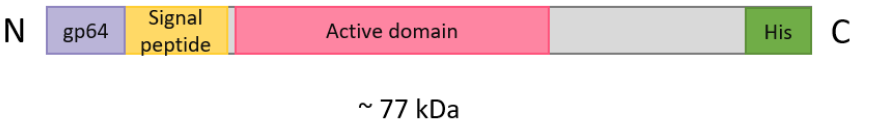
Figure 2. Schematic structure of the recombinant full-length β -gal from A. vulgaris (GenBank: A0A0B7AQJ9). The full-length protein consists of a putative N-terminal signal peptide (yellow), a putative active domain (red), and further gene sequence (grey). A gp64 leader sequence (purple) for secretion out of Sf9 insect cells was added to the N-terminus, and a 6x His-tag (green) for purification was added to the C-terminus of the protein. A short 3 amino-acid linker was added to the gene at the N- and C-terminus to connect gp64 leader sequence and 6x His-tag (not shown in the figure). The presence and activity of the expressed β -gal protein was analyzed in supernatant (secreted proteins) and lysate (soluble proteins).